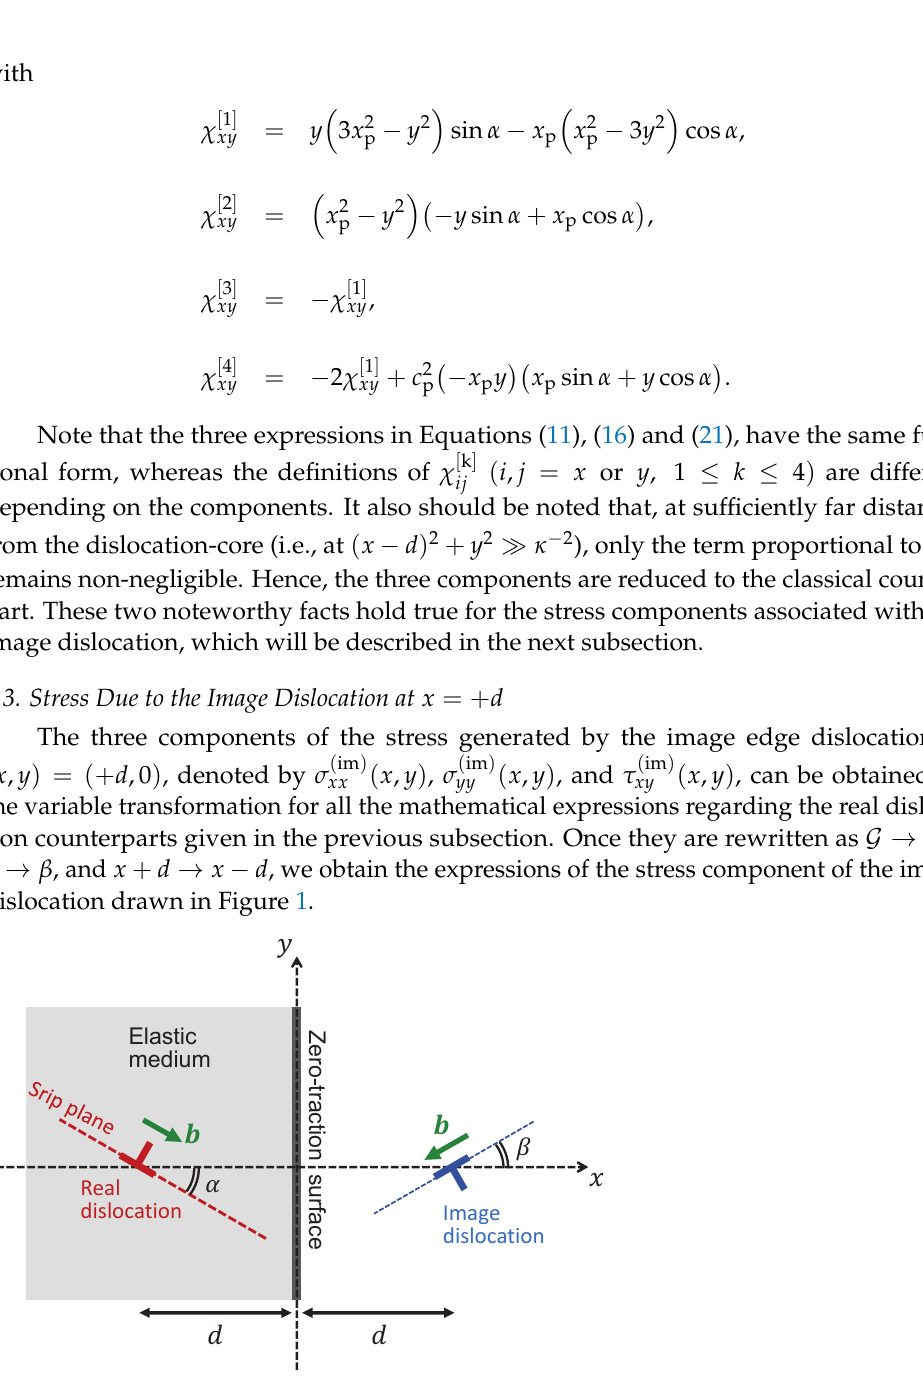
Figure 1. Real edge dislocation ( left ) existing inside a semi-infinite elastic medium and image edge dislocation ( right ) virtually introduced for convention. The Burgers vectors of the two dislocations are assumed to be oblique relative to the x -axis at angles α and β ,